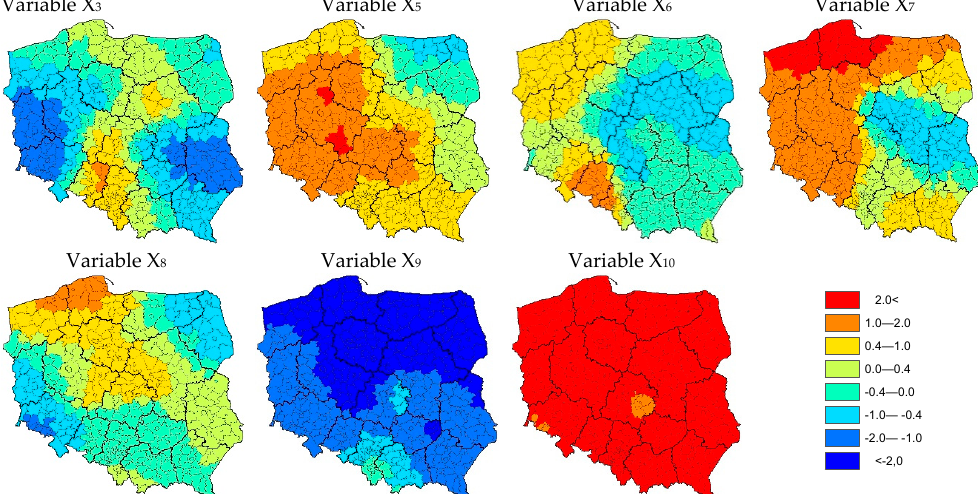
Figure 5. Spatial distribution of the parameters at local variables in the MGWR2 model (standardised variable values were used for estimation). Source: own research.